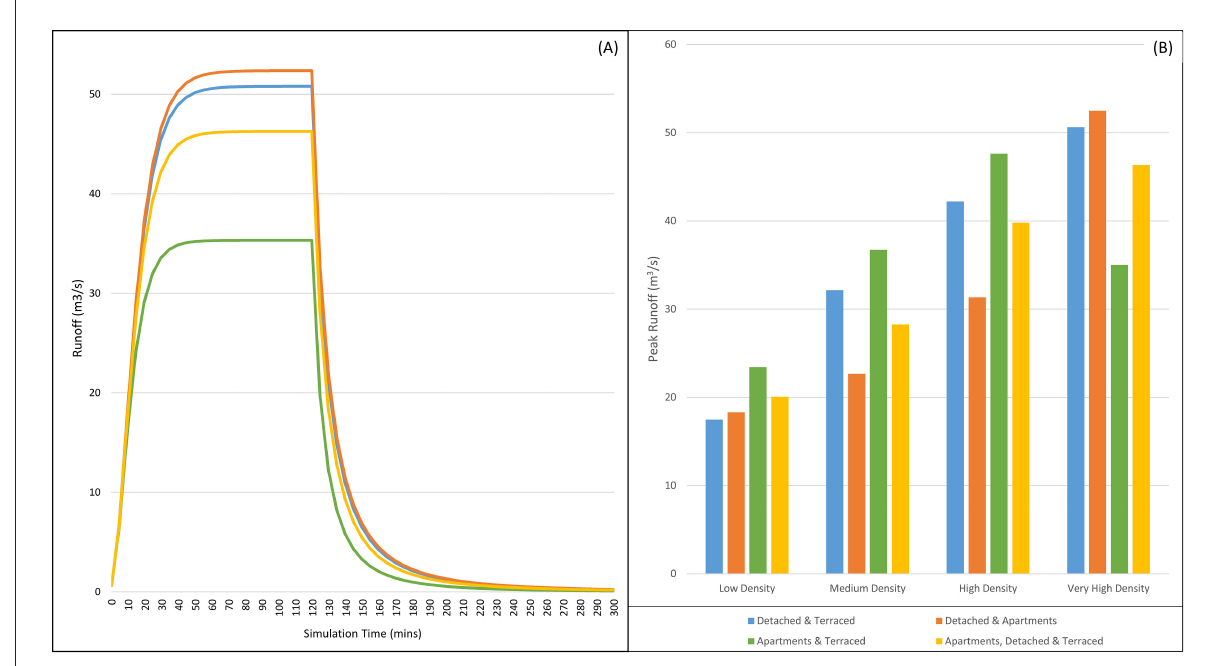
FIGURE8 Runoff from a 1-in-10 year 2-h duration rainfall event in each of the tile configurations without SuDS infrastructure: (A) hydrograph of the very high density scenario; (B) peak discharges for the different housing typologies under the different density conditions.